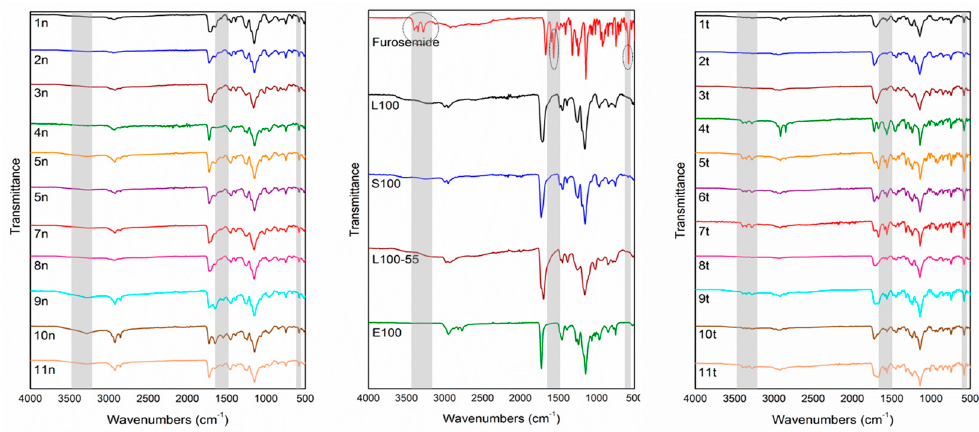
Figure 4. FTIR spectra of the raw materials, electrospun nanofibrous mats (formulations 1n–11n) and physical mixture matrix tablets (formulations 1t–11t).